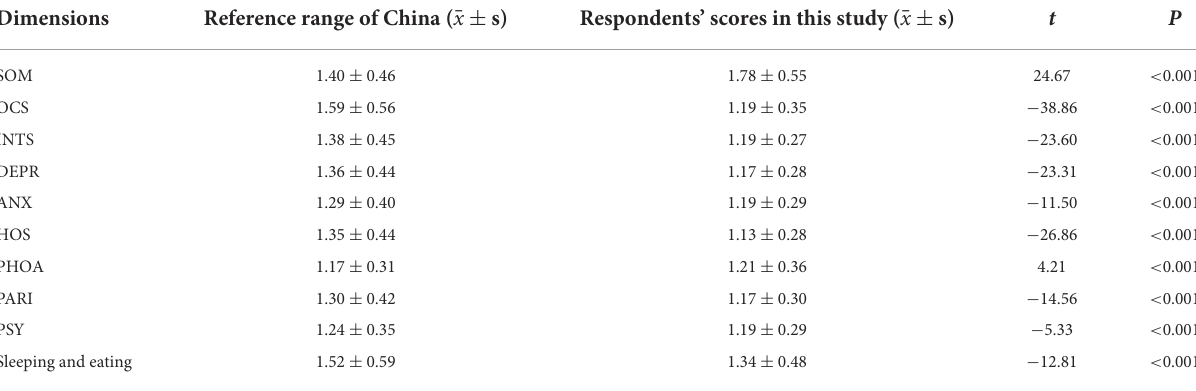
TABLE 2 Assessment results of the respondents’ scores in all dimensions of SCL-90-R.